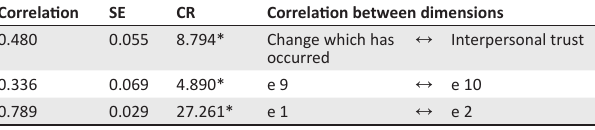
TABLE 4: Structural equation modelling correlations coefficients within organisational